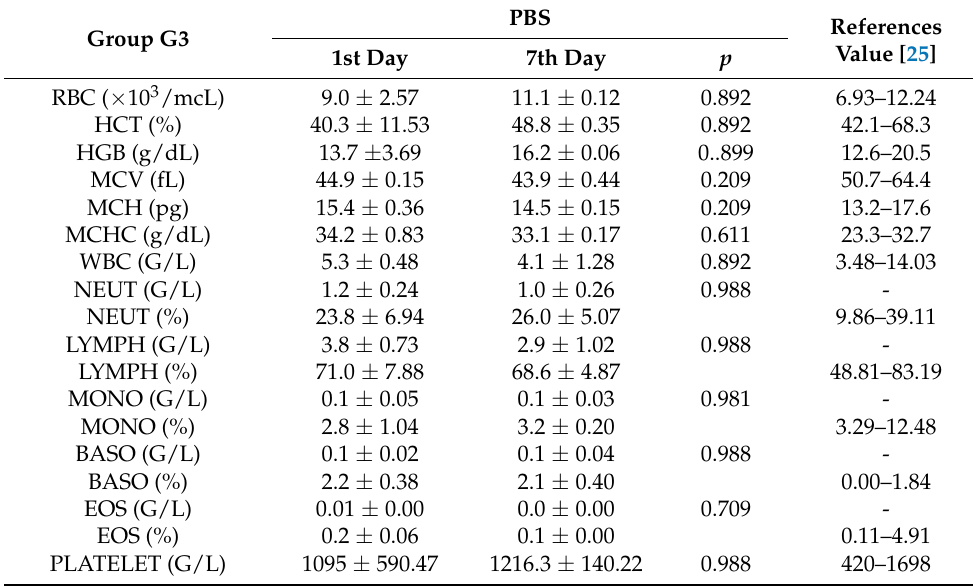
Table A3. Hematological parameters of blood of BALB/c mice at 1 and 7 days post injection with PBS.